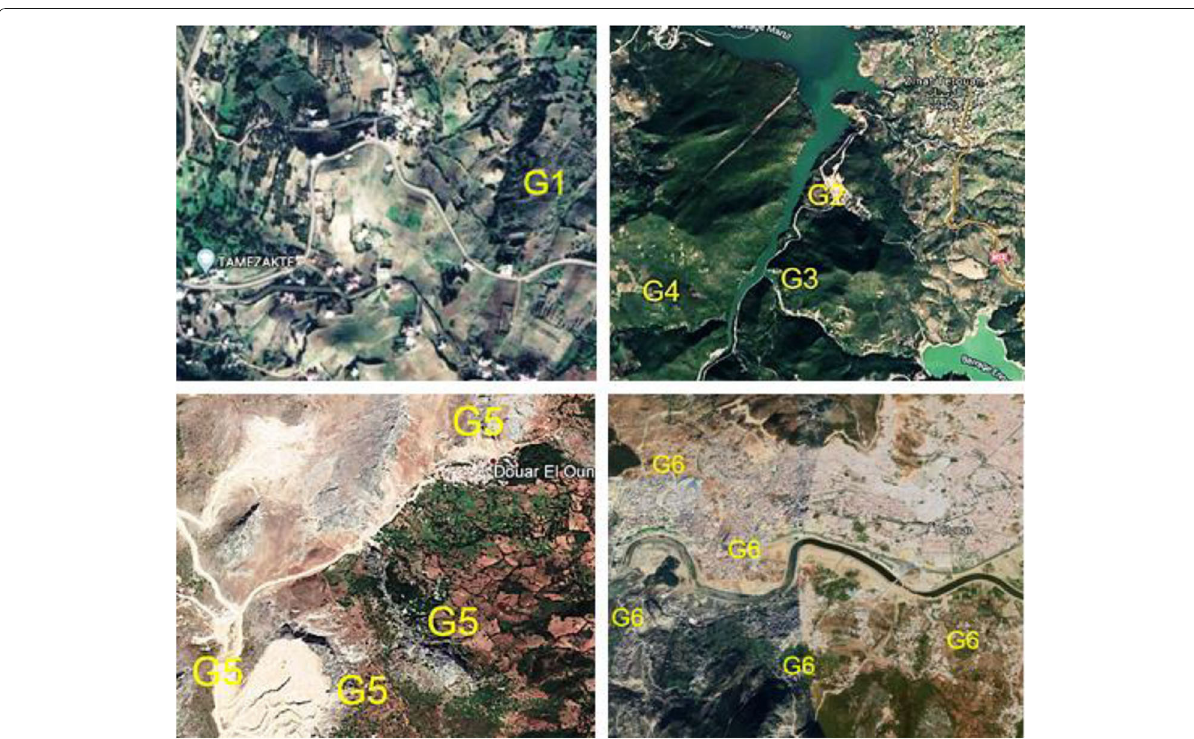
Fig. 5 Some examples of mass movements (G) in Tétouan province: The Tamezakht Movement (G1). The movements of Koudiat Krikra near the Nakhla and Martil dams (G2; G3; G4). The Slope Movements in the El Onsar Pass (G5). The mass movements on the 2 slopes of Oued Martil (G6) with Tétouan and its surroundings (Kourrat Sbaa, Khandak Ezzerbouh Samsa , Bouanan , Kaa El Hafa etc)